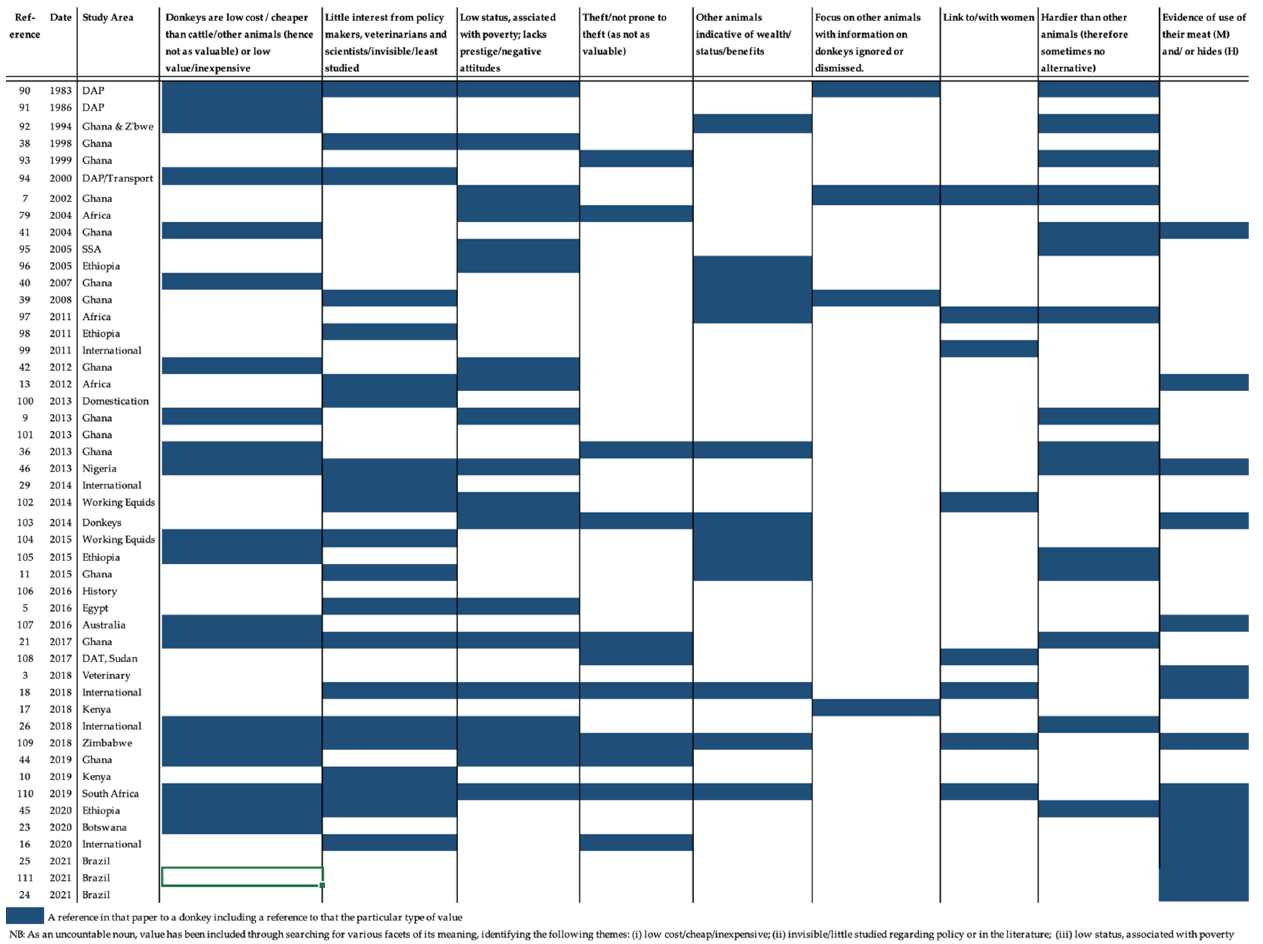
Figure A1. References to donkeys being under-valued in the literature [90–111].